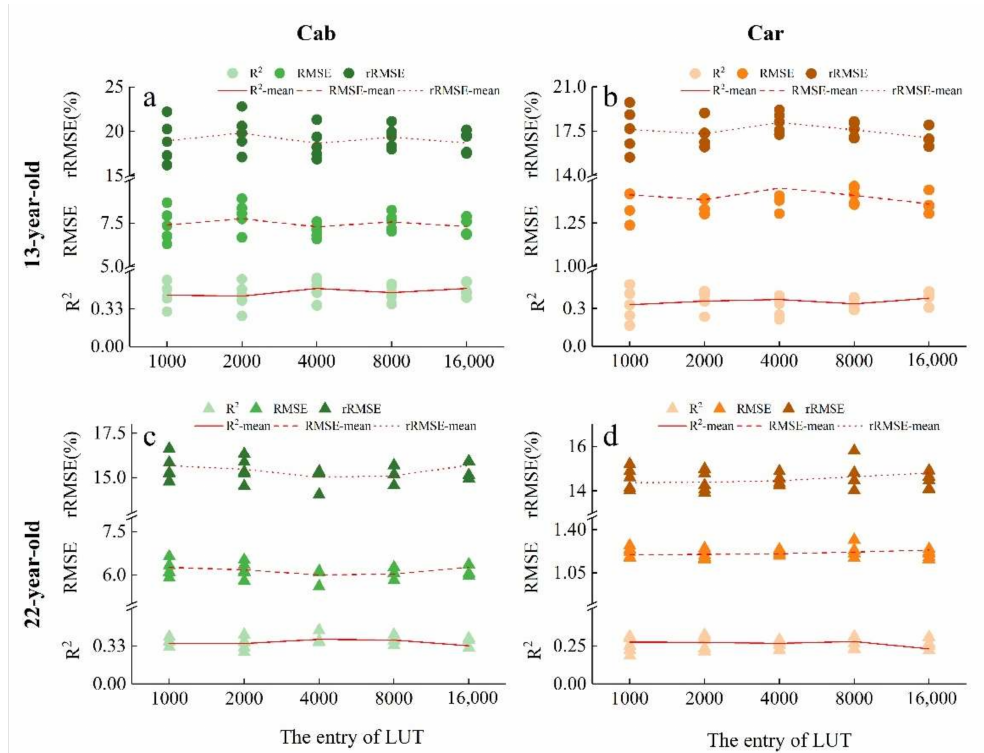
Figure 7. Summary of Cressie-Read function estimating accuracy of Cab and Car content at different ages. ( a , c ): accuracy results of Cab content; ( b , d ): accuracy results of Car content; ( a , b ): accuracy results of 13-year-old part samples; ( c , d ): accuracy results of 22-year-old part samples. Each entry result of Cab and Car for two ages was repeated five times. Note: Cab = total chlorophyll content ( µ g · cm − 2 ); Car = carotenoids’ content ( µ g · cm − 2